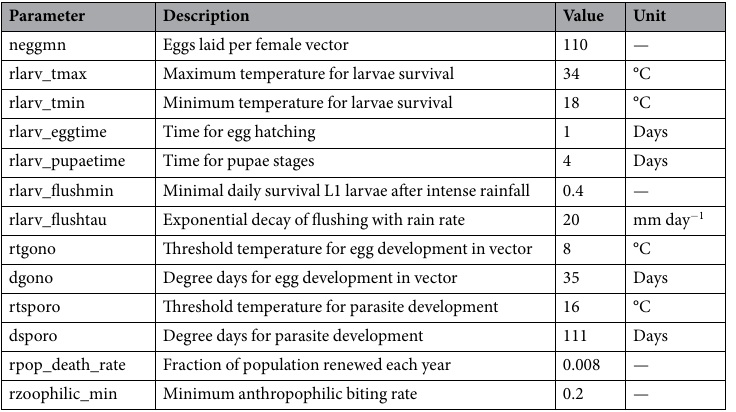
Table 1. List of parameters with their modified values in the VECTRI model set up for the Odisharegion (“–” symbol indicates unit less).